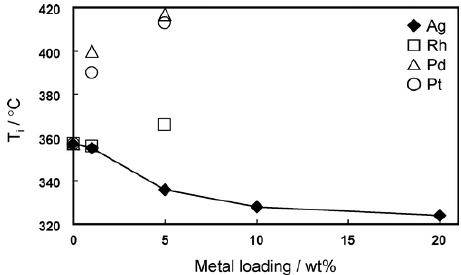
Figure 7. Soot oxidation activity (T i ) of metal-loaded CeO 2 measured in a flow of 10% O 2 and N 2 balance. Tight-contact soot/catalyst mixtures with a weight ratio of 1/20 were heated at the rate of 10 °C·min − 1 . Reproduced from Ref. [48] with the permission from the American chemical society.